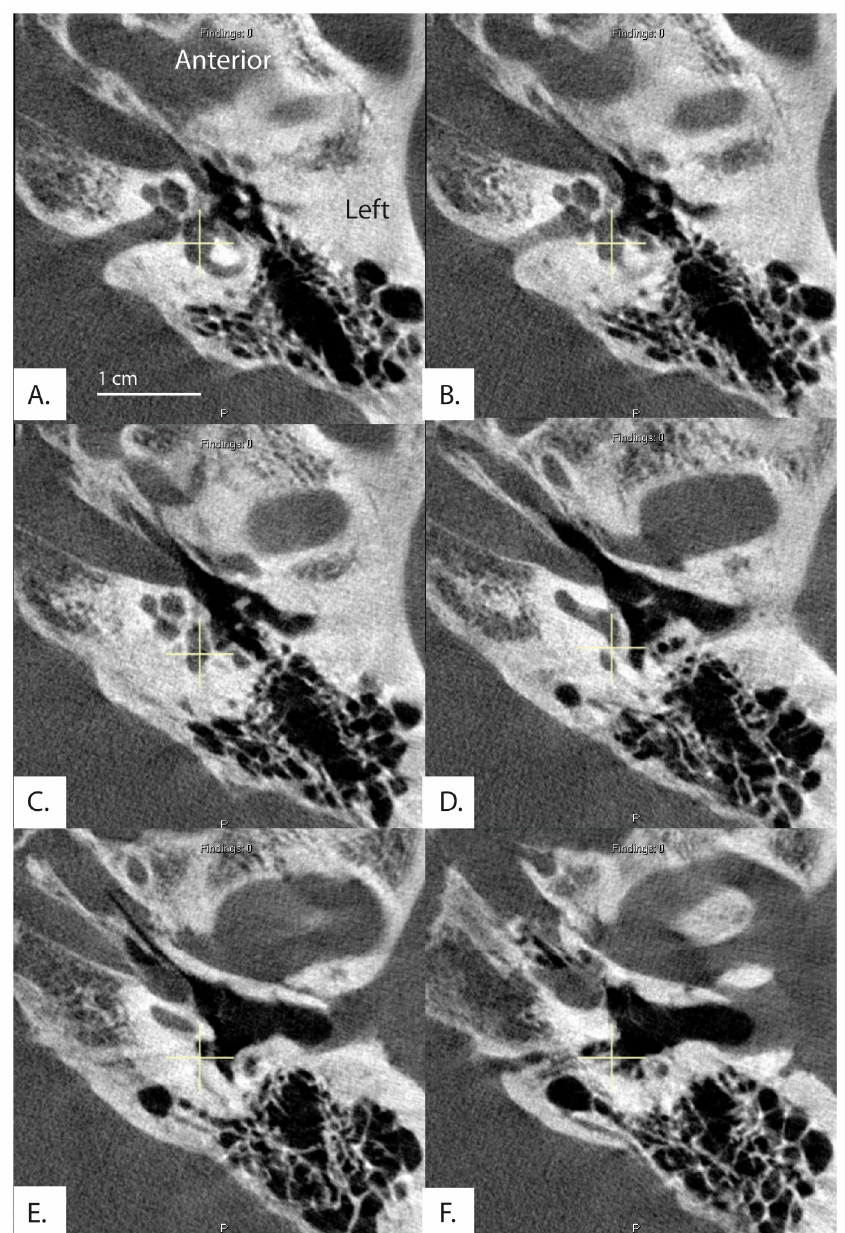
Figure 5. Image formatted in the plane of the horizontal semicircular canal. Images progress superior to inferior ( A – F ). Exit of the vestibular aqueduct in the opercular area of this patient (369L) was difficult to visualize and therefore measure in both